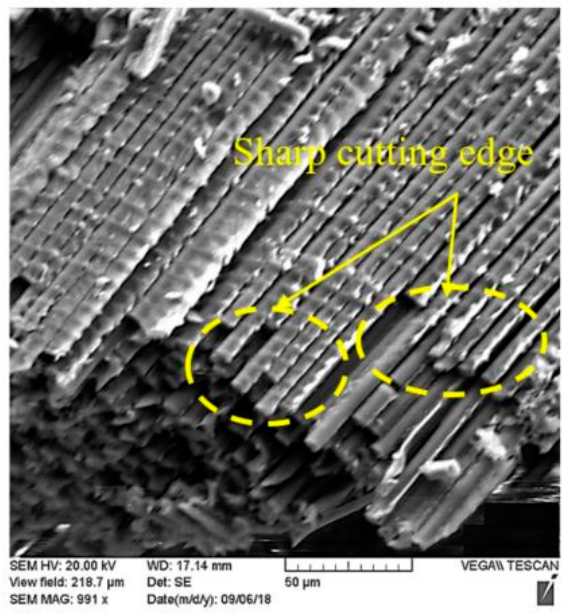
Figure 7. Effect of drilling technique on the carbon fiber-reinforced polymers (CFRP) fibers ( a ) CD ( b ) VAD.